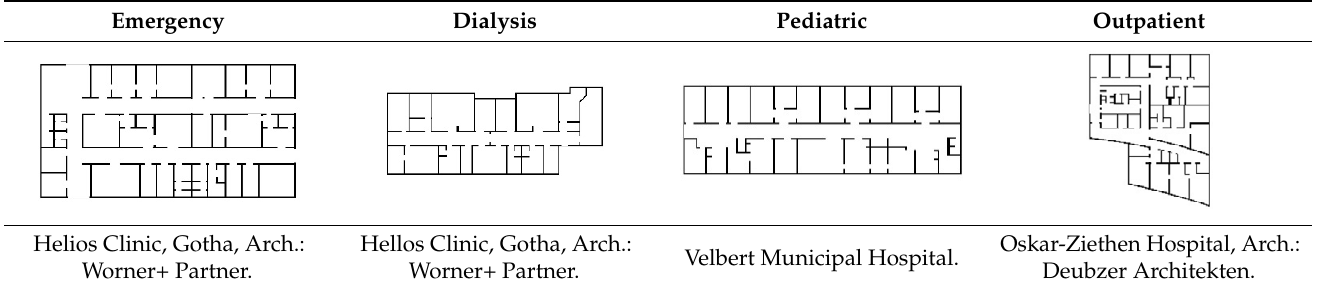
Table 10. Examples used in the space syntax analysis. Adapted from ref. [18].